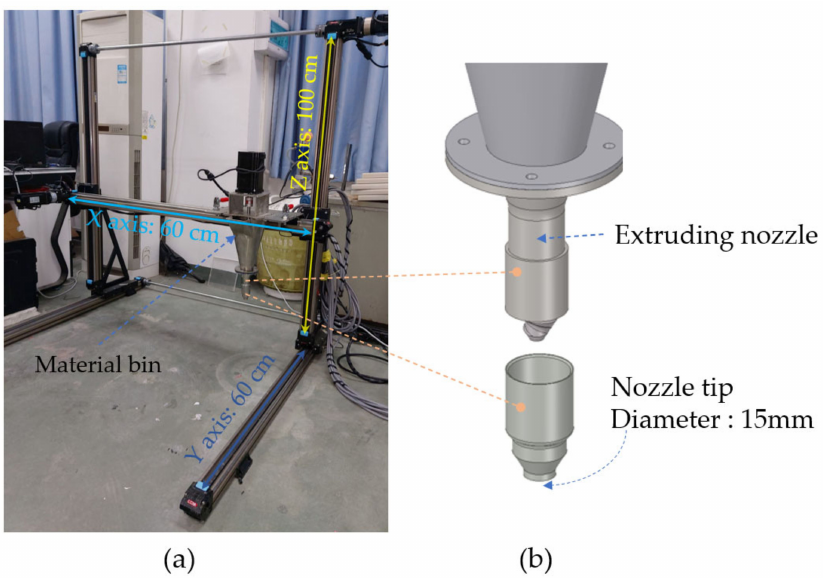
Figure 2. The 3D concrete printer; ( a ) gantry-type printing device; ( b ) extruding nozzle